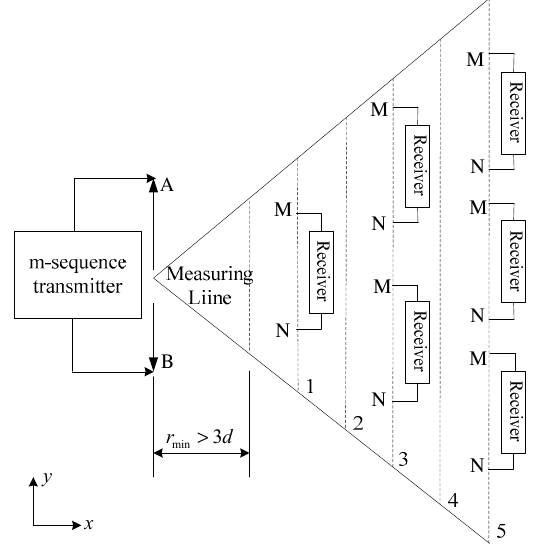
Figure 1. Observation system of pseudo-random sequence electromagnetic detection.